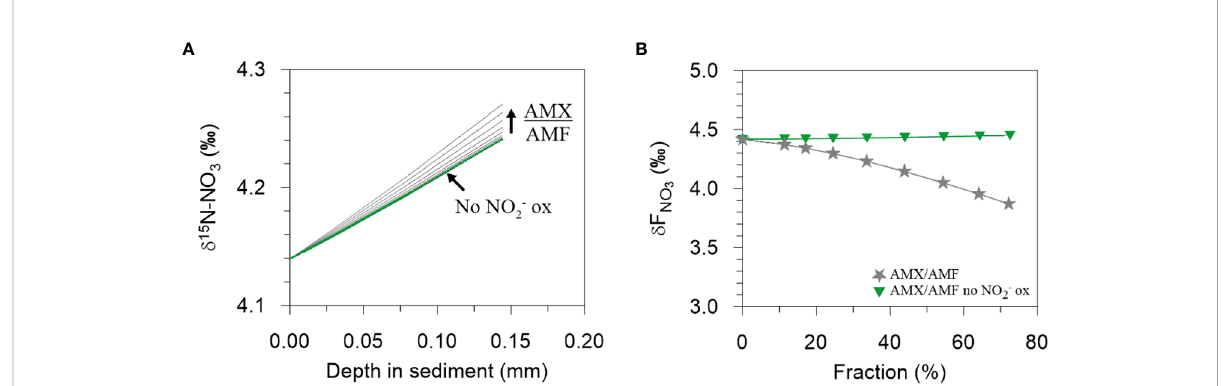
FIGURE 6 The effect on increasing AMX/AMF on (A) the d 15 N-NO 3 of porewater NO 3- at the sediment surface and on (B) the d 15 N of the NO 3- fl ux into the sediment. In (A) , an increase in AMX/AMF leads to a steepening of the d 15 N-NO 3 gradient and consequently, in (B) , to a decrease in d F curve in (A) has a corresponding symbol in (B) . The green lines in (A) are almost superimposed, re fl ecting a negligible change in d 15 N-NO 3 when NO 2- oxidation by AMX is turned off. See Figure 5 for more